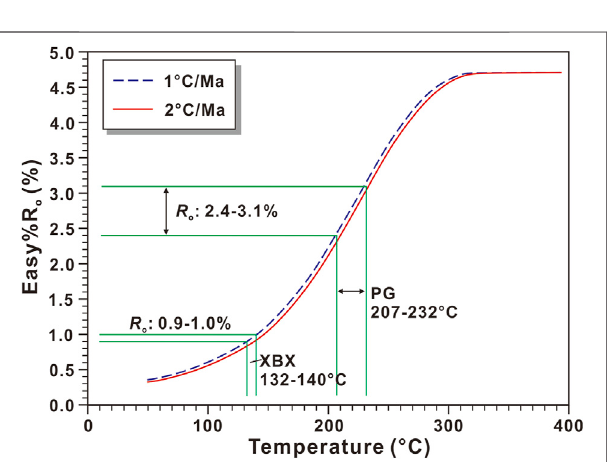
FIGURE 4 | The evolution of the vitrinite re fl ectance (R o ) vs. temperature based on the Easy%R o model (Sweeney and Burnham, 1990). Note the maximum burial temperatures of the Permian shale in the Xibeixiang (XBX) outcrop and the Puguang (PG) gas fi eld are 132 – 140 and 207 – 232 ° C,